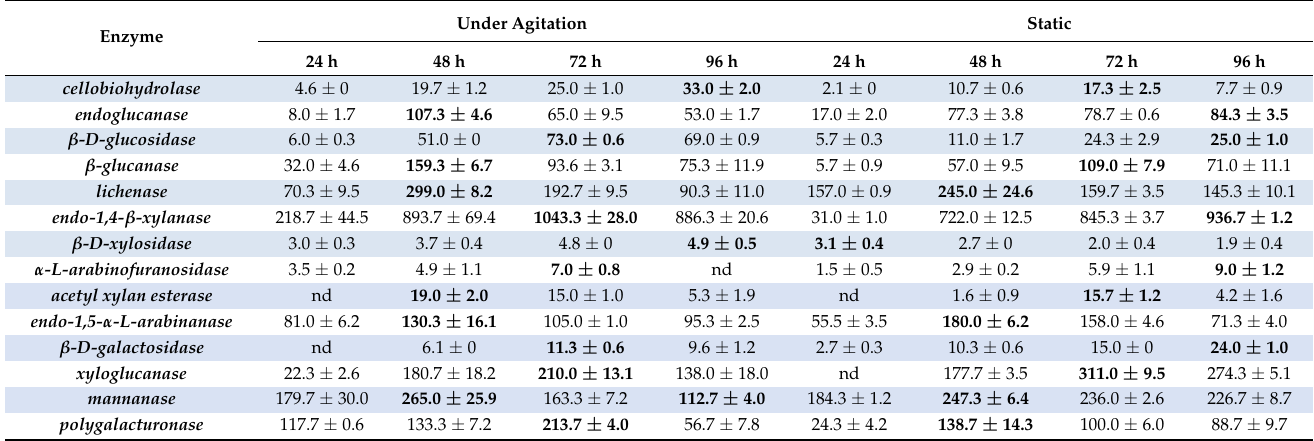
Table 1. Enzymatic activities of Thermothelomyces thermophilus LMBC 162 cultivated with jatoba seeds during different times. Enzyme